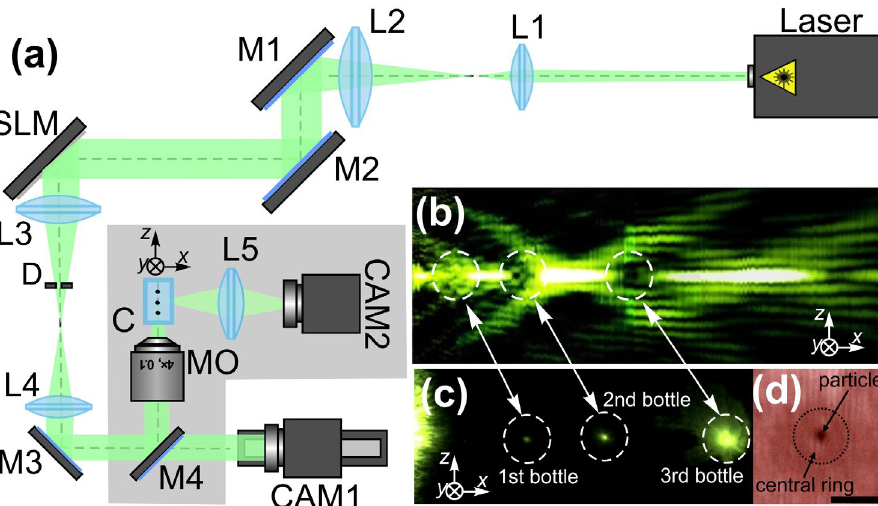
Figure 10. Optical trapping with multiple optical bottles generated an axicon with phase jumps. ( a ) The optical setup used for the generation of the desired multiple optical bottles: Laser is a solid-state laser (λ = 532 nm), L1, L2, L3, L4, and L5 are lenses with focal lengths of 25, 150, 500, 150, and 50 mm respectively, M1, M2, M3, and M4 are mirrors, SLM is a reflective spatial light modulator HOLOEYE PLUTO VIS (1920×1080 pixels, pixel size of 8 μm), D is a circular diaphragm, MO is a micro objective (4×, NA = 0.1), C is a glass cuvette, CAM1 and CAM are video cameras (TOUPCAM UHCCD00800KPA, 1600 × 1200 pixels, 3.34 μm pixel size). ( b ) The longitudinal intensity distribution of the generated multiple optical bottles. The white dashed circles show the dark regions of the generated traps. ( c ) An image of three agglomerations of carbon nanoparticles (indicated by the white dashed circles) trapped using the generated multiple optical bottles (Visualization 1). In the left part of the image, the light scattered by a wall of the glass cuvette is shown. ( d ) An image of the particle trapped in the first optical bottle observed in the transverse (xy) plane (Visualization 2). The scale bar is 20 μm.